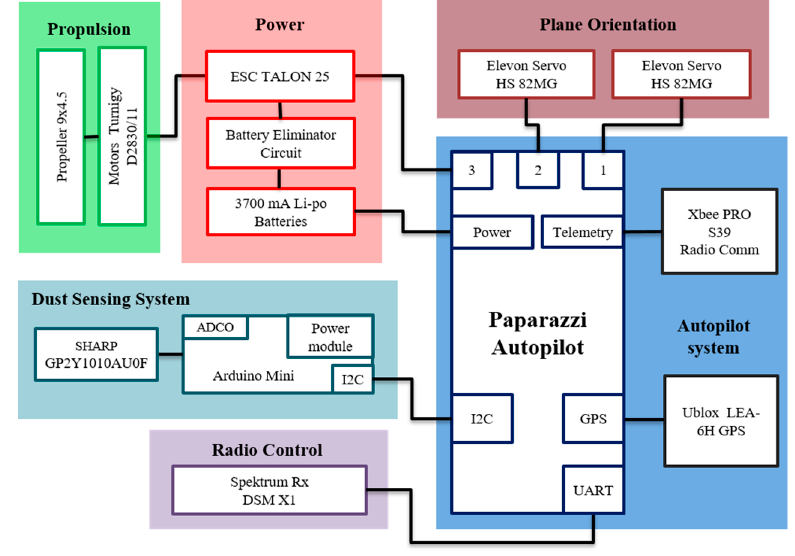
Figure 1. System architecture for the fixed-wing UAV with dust sensor.